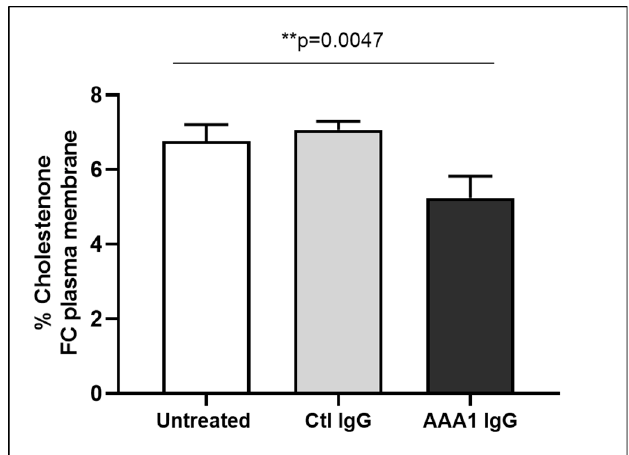
Figure 3. Free cholesterol in membrane. Monolayers were labeled with 3 μ Ci/mL [3H] cholesterol for 24 h in RPMI medium with 10% FCS, control IgGs or anti-apoA-1 IgGs 40 μ g/mL. Cells were then washed and incubated with 1 U/mL cholesterol oxidase enzyme in Dulbecco’s Phosphate Buffered Saline (DPBS) for 4 h at 37 °C. Data are expressed as the mean ± SD of the measurements done in triplicate and repeated three times ( n = 3). Statistical differences were determined by one-way analysis of variance (one-way ANOVA), with p ≤ 0.05 being considered significant.